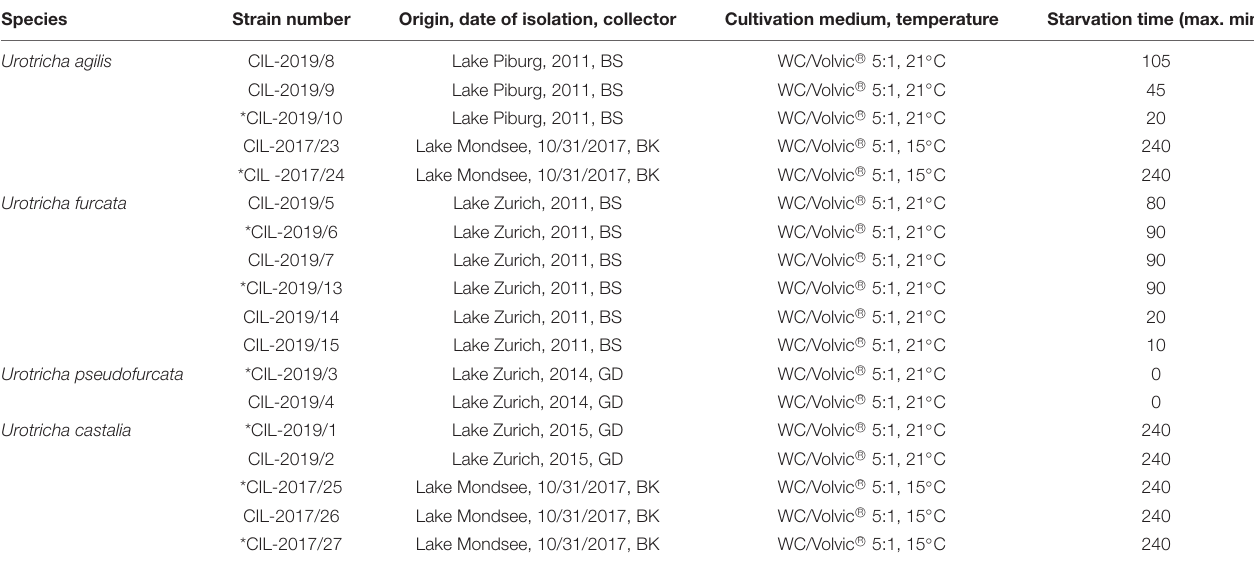
TABLE 2 | Urotricha strains based on molecular sequences (all strains) and on morphology (marked with an *): species assignment, strain number, isolation details (location, date, collector), cultivation conditions, maximum starvation time before sequencing. Species Strain number Origin, date of isolation, collector Cultivation medium, temperature Starvation time (max.